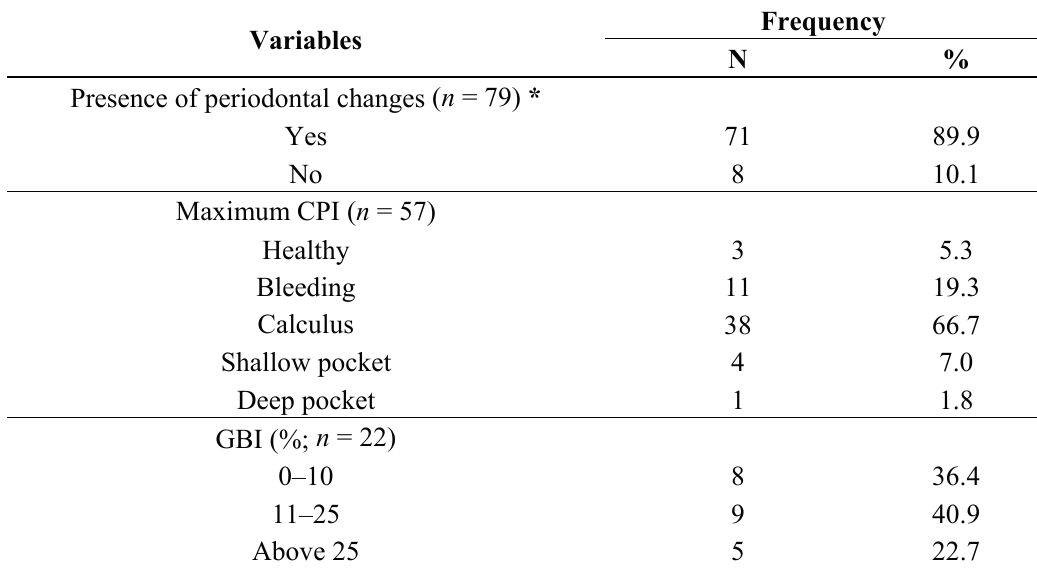
Table 4. Distribution of children and adolescents with CP according to the presence of periodontal changes in CPI and GBI measured.